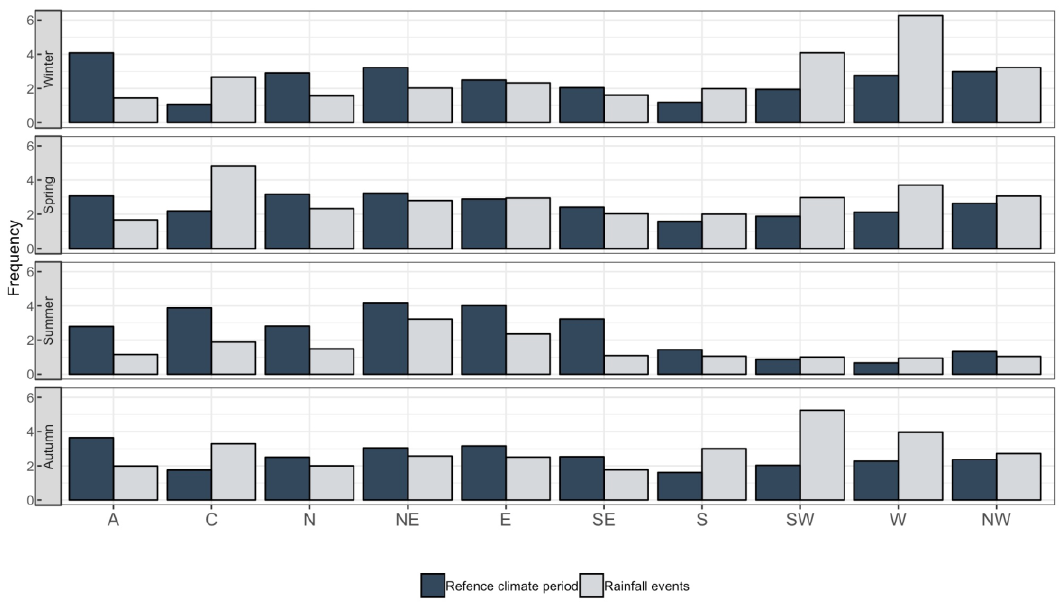
Figure 5. Frequency of the reference climate period (1981–2010) and in the study events (1985–2015) in the WTs in each season.